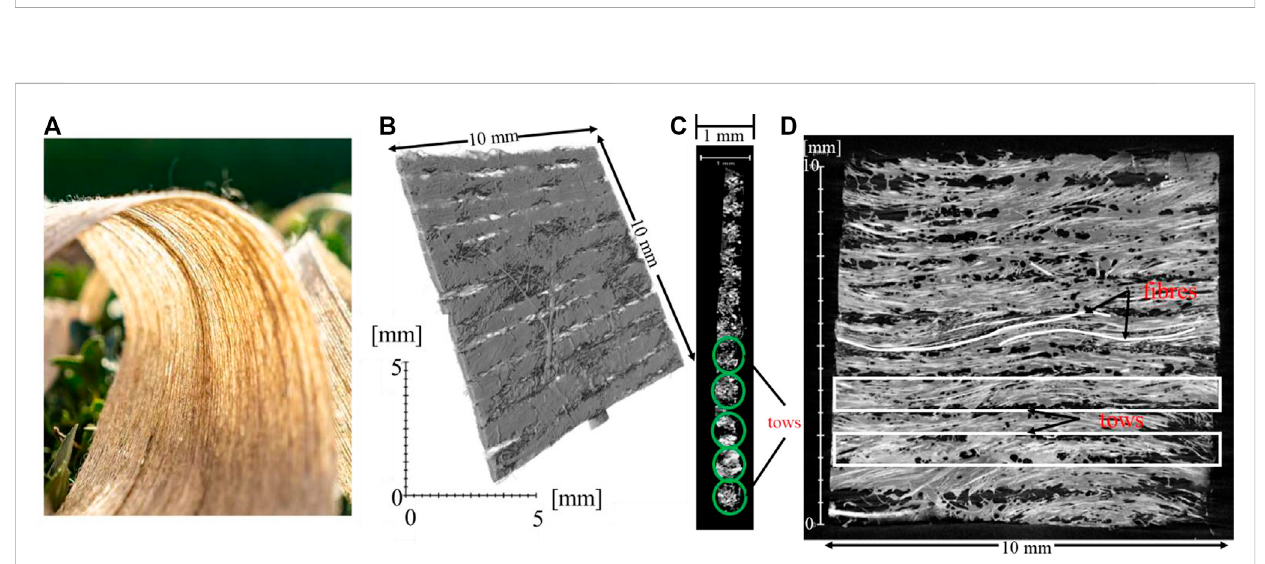
FIGURE 2 (A) pre-consolidated unidirectional Flax/Polypropylene (PP) commingled tape, (B) a binarized image from X-ray microtomography (µ-CT), (C) tow cross sections, (D) in-plane view of unidirectional Flax/Polypropylene (PP) captured by µ-CT.